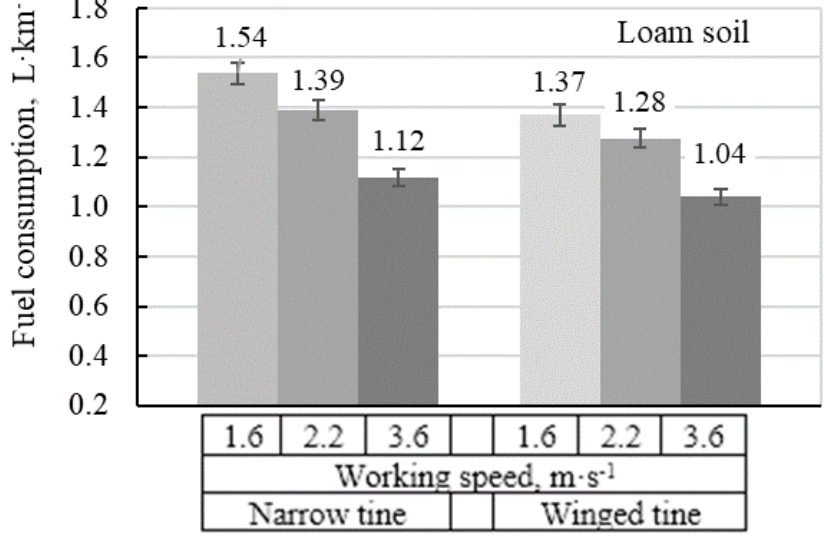
Figure 12. Dependence of fuel consumption on speed and tine types on loam soil.